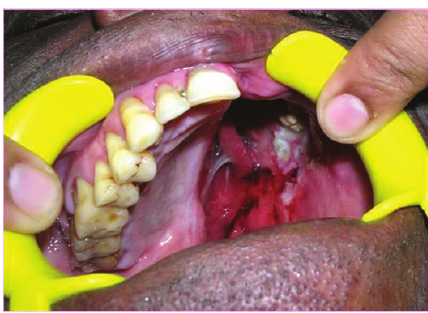
Figure 3: Completed prosthesis.